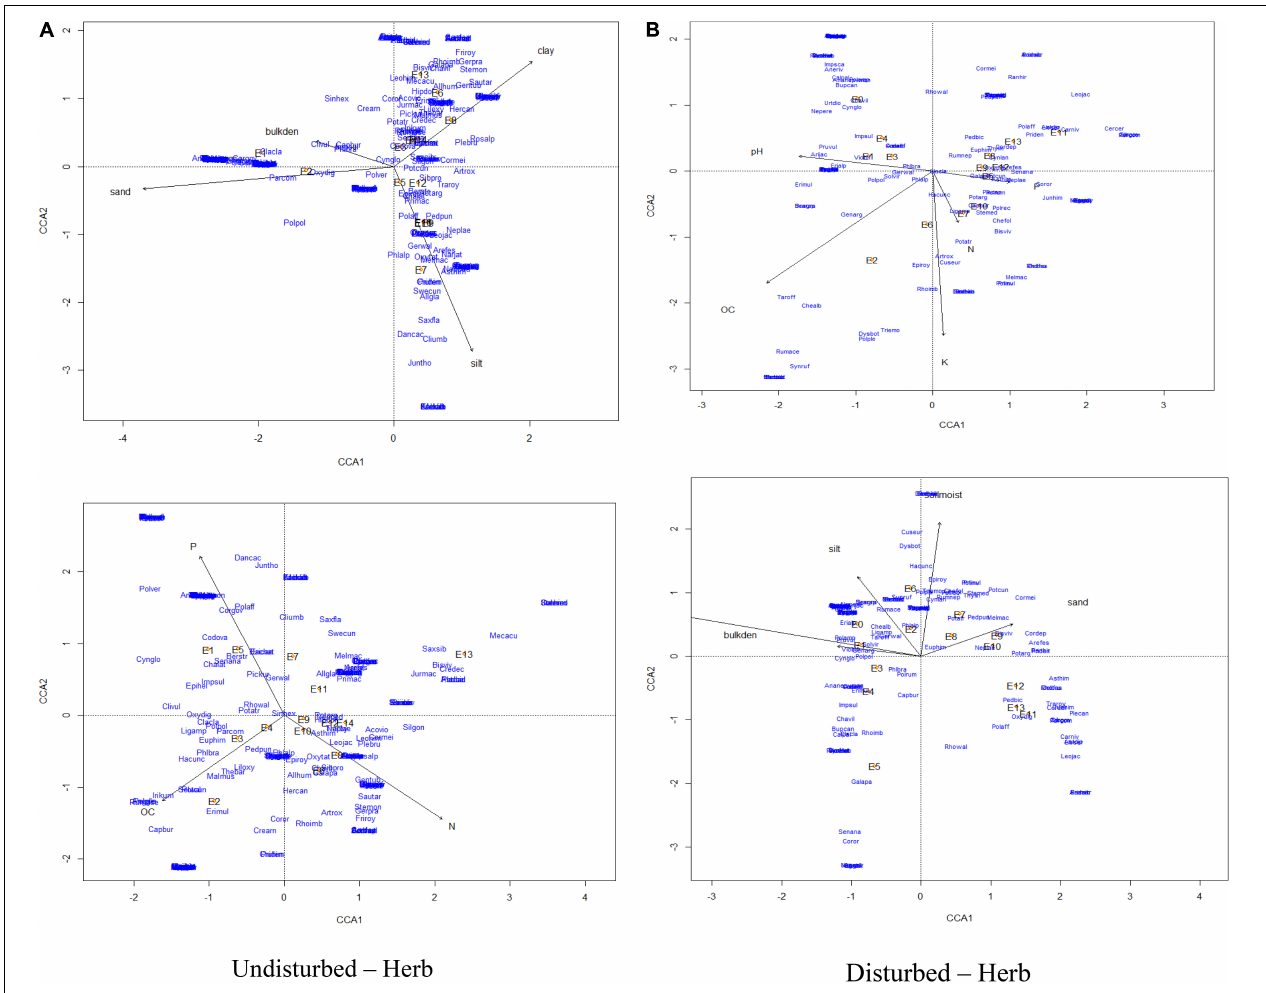
FIGURE 11 | Canonical correspondence analysis of vegetation abundance and elevation (represented by E) overlaid to soil parameters at a p.max = 0.25 for undisturbed and disturbed quadrates of herbs in